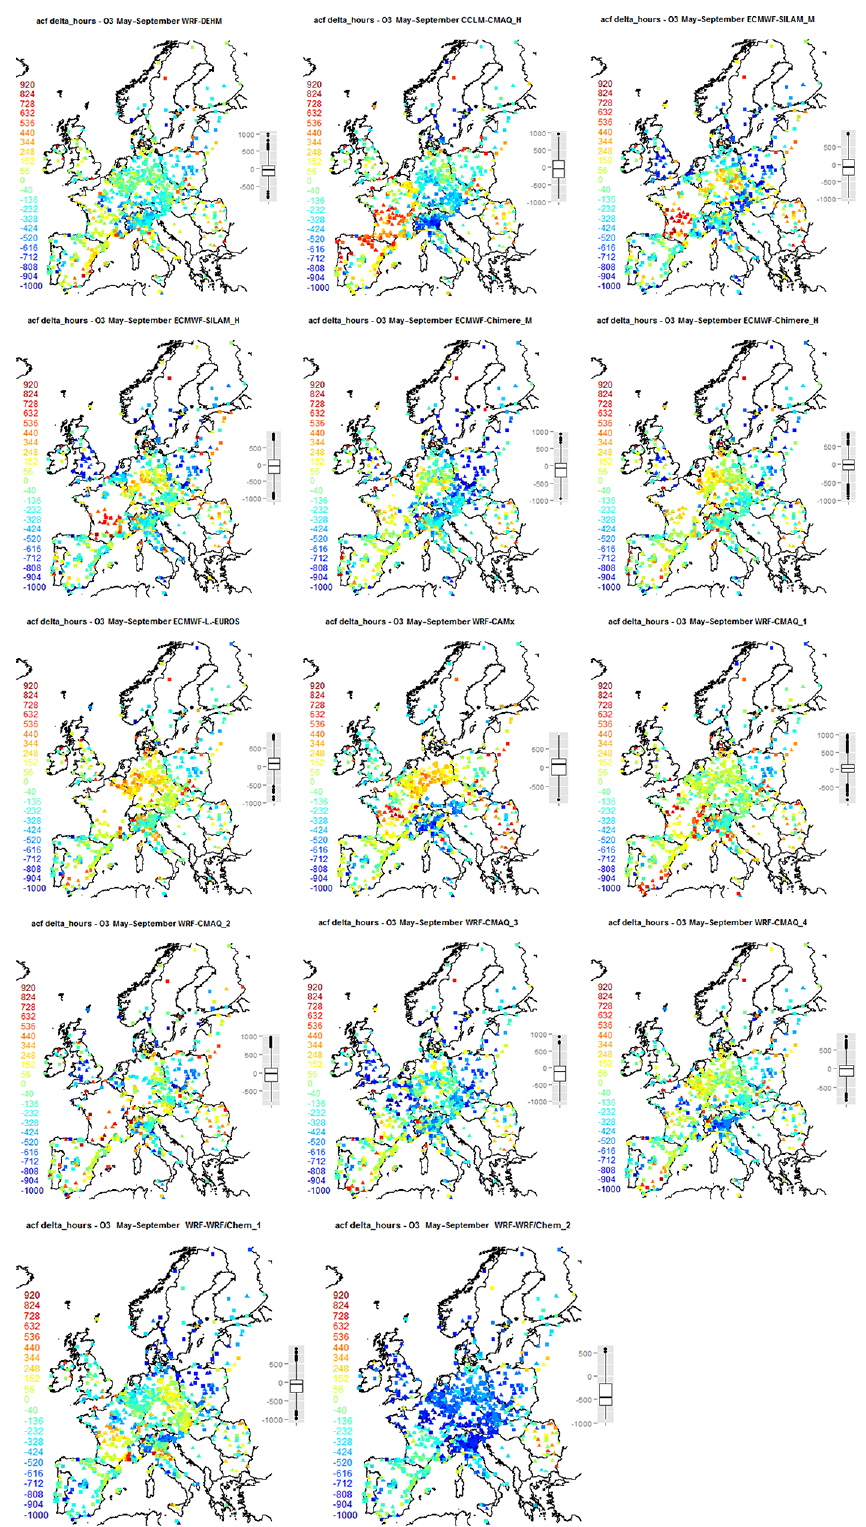
Figure 28. Spatial map of the ozone monitoring stations colored based on the “delta hour” values, i.e., the difference in hours between the zero of the autocorrelation function (acf) for the modeled ozone minus the zero of the acf of the observed one. The acf is calculated on the long-term component for the months of May to September. Negative values indicate too-short memory and excess of removal (vice versa for positive values). The box on the right summarizes the delta hour percentile